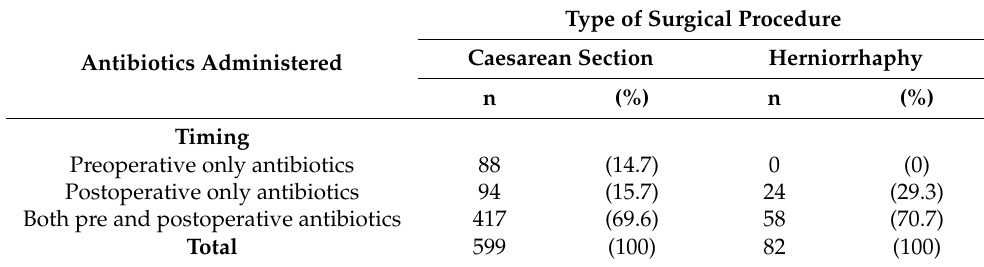
Table 1. Timing of antibiotics administered in patients who underwent Caesarean section and herniorrhaphy surgeries at the Bo regional hospital, Sierra Leone, November 2019 to October